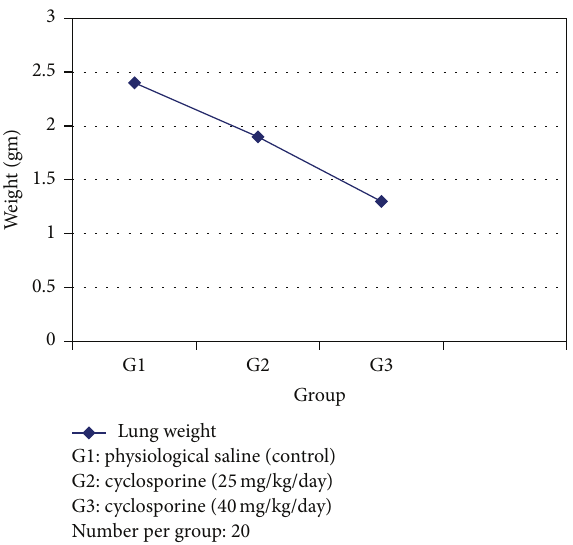
Figure 1: The effect of cyclosporine different doses on the rats’ lung